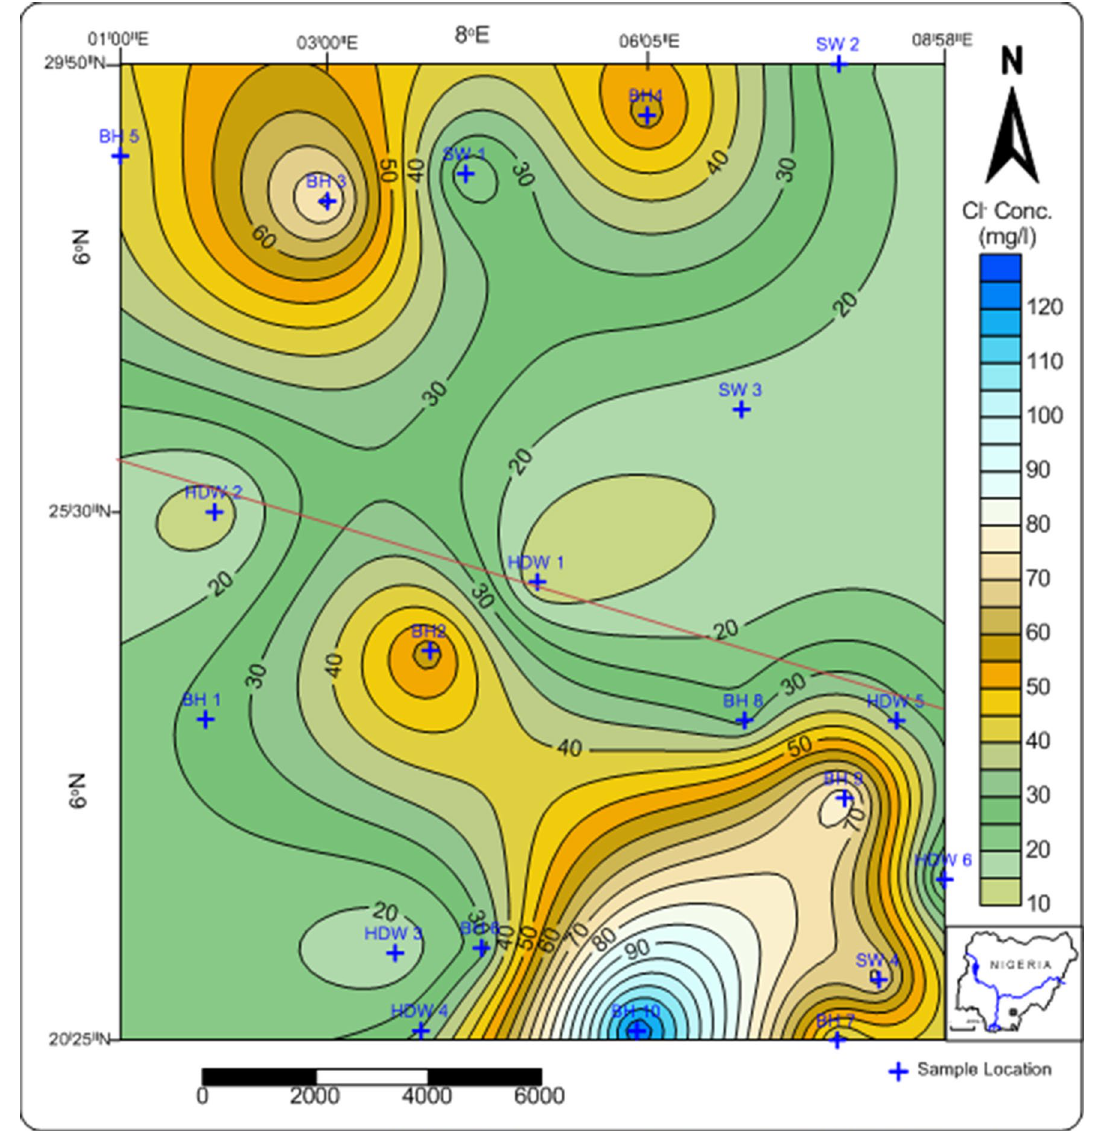
Fig. 21 Map showing the dispersion trend of chloride ion. Note : Perpendicular line indicates groundwater